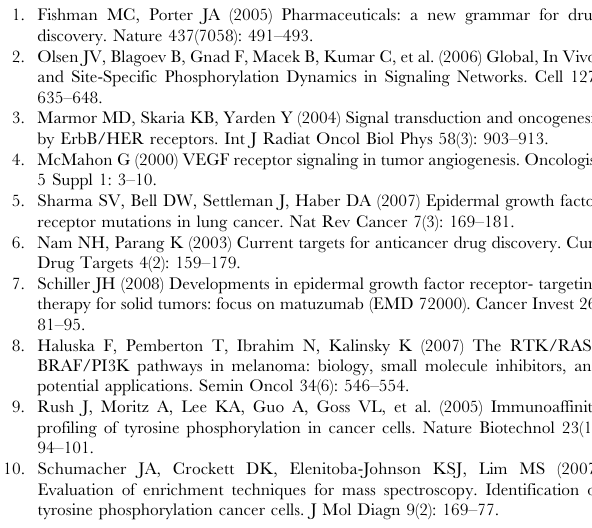
Table S1 Overall classification of tyrosine phosphopeptides based on functional category of proteins. Summary of all the tyrosine phosphorylation sites that are specific to insulin RTK, EGF RTK and sites common to starved control cells/insulin/EGF treated cells. The conserved position of tyrosine on respective human ortholog and paralog are given for each phosphorylated site on Drosophila proteins. The Swiss-Prot protein ID for each human ortholog and paralog is also provided.